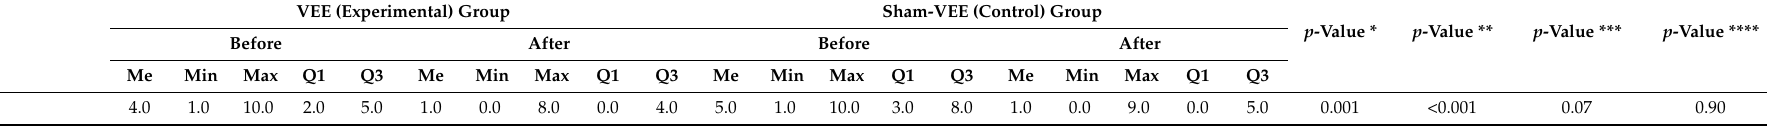
Table 4. Intragroup and intergroup comparisons of the changes in VAS scores before and after the PA intervention. VEE (Experimental) Group Sham-VEE (Control) Group Before